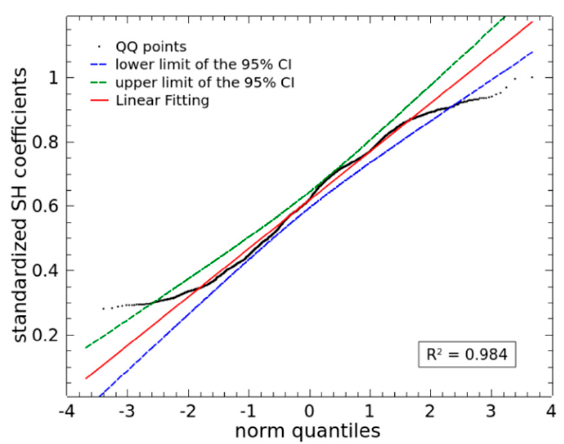
Figure 1. Quantile-quantile (QQ) plot with black points representing standardized spherical harmonic (SH) coefficients versus a normal distribution. The red line displays the linearity of the QQ points. The blue and green dashed lines present the lower limit and upper limit of the 95% confidence interval, respectively.